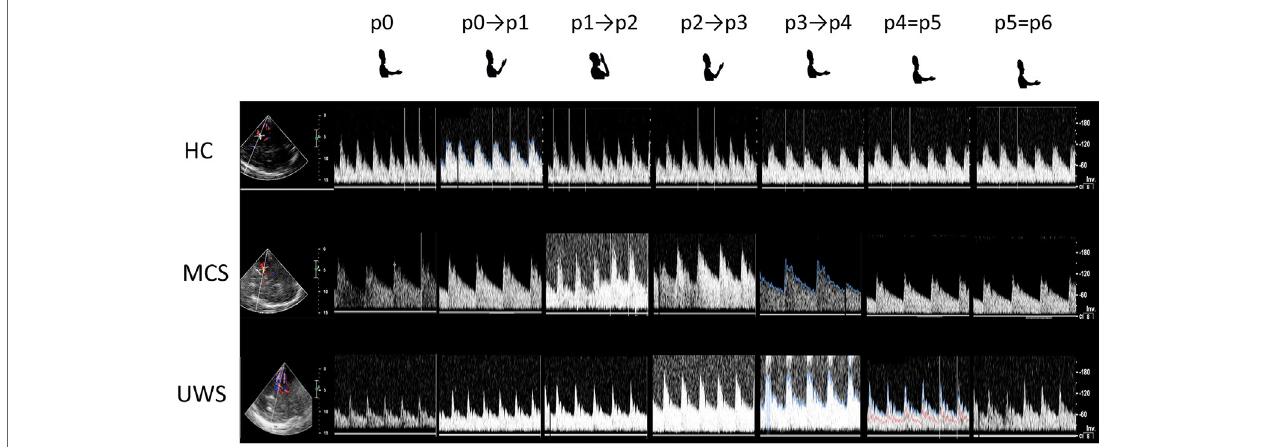
FigUre 5 | Shows the transcranial Doppler waveforms (on the right) with color Doppler (on the left) from left middle cerebral artery during passive mobilization across the six hand positions (p) explored in a representative subject for each group [healthy controls, minimally conscious state (MCS), and unresponsive